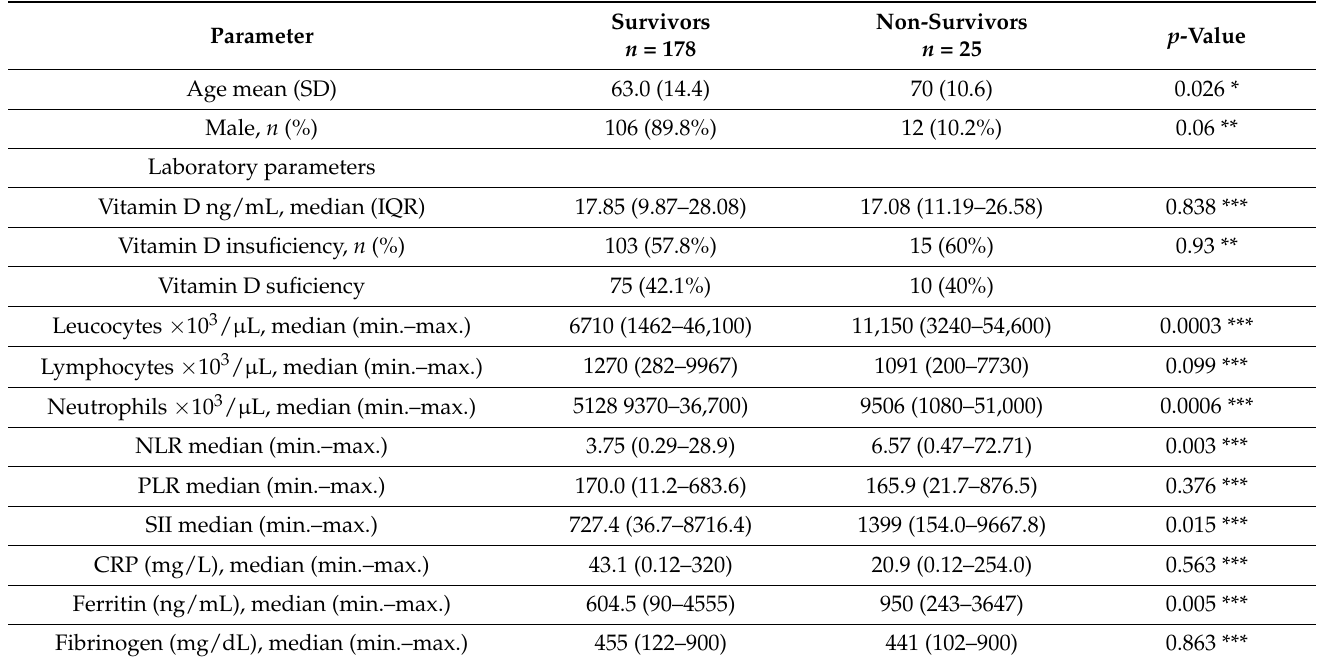
Table 4. The characteristics of the surviving vs. non-surviving patients as related to the inflammatory parameters and vitamin D status.